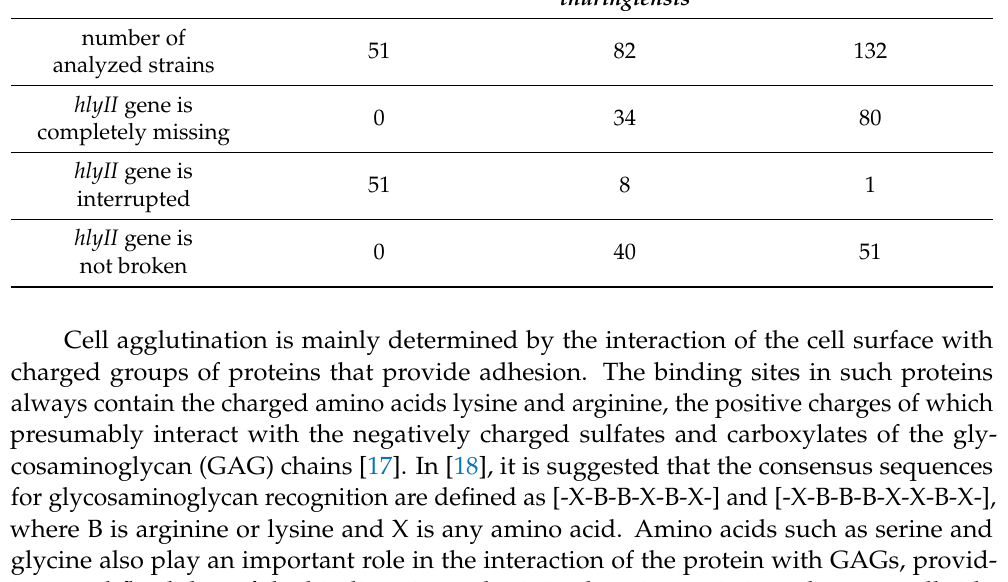
Bacillus thuringiensis 51 82 132 0 51